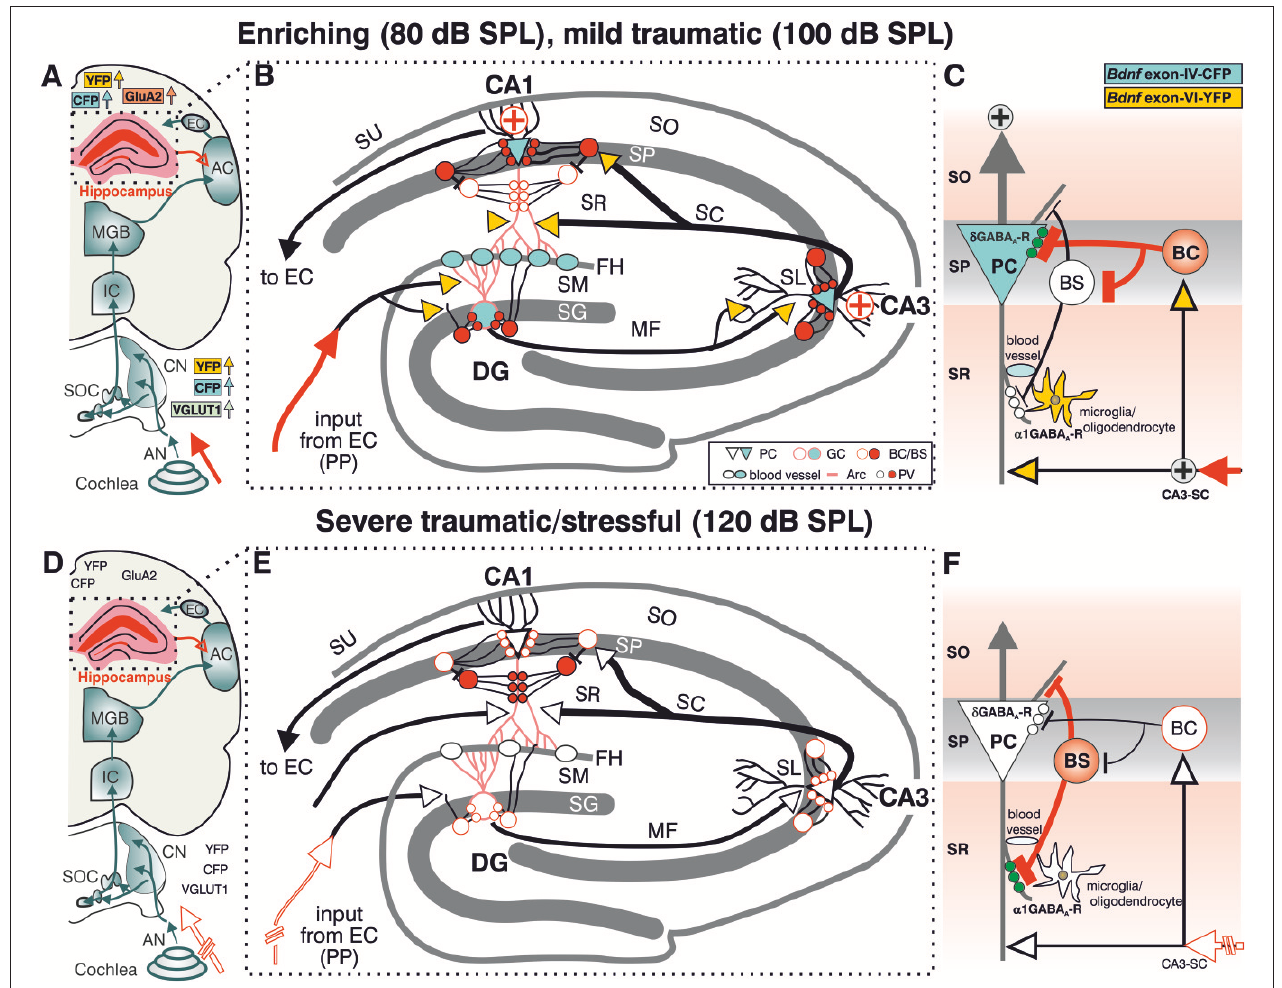
FIGURE 7 | Summary of the location pattern of CFP (blue), YFP (yellow), neuronal (PV) and activity markers (Arc) in the hippocampus. Depicted is the situation in response to enriching or mild traumatic events (80/100 dB SPL) (A–C) or to severe traumatic/stressful events (120 dB SPL) (D–F) . (A,D) Schematic drawing of the auditory pathway including hippocampal connections (red open arrow). (B,E) Schematic drawing of hippocampus with perforant path (PP). (C,D) Schematic drawing of dendritic (BS) and somatic (BC) inhibitory inputs onto a pyramidal cell (PC). CFP, YFP, VGLUT1 ( A , light green), GluA2 ( A , light orange), Arc ( B red dendrites), PV ( B red filled circles), and the δ subunit containing GABA A receptors in PCs (green dots in C ) were shown to be mobilized after exposure to 80 or 100 dB SPL (A–C) but not to 120 dB SPL (D–F). (C,F) The cooperative transcript-specific BDNF release may drive a long-lasting reduction of dendritic ( C , α 1 subunit containing GABA A receptors, white small dots) and increase of perisomatic inhibition ( C , δ subunit containing GABA A receptors, green small dots) of CA1PC by PV expressing inhibitory interneurons (BS, BC) and in parallel possibly improve the recruitment of vascularization ( B,E , blood vessels). This central facilitating or adaptive responsiveness ( A–C , solid red arrow indicating increased input activity) is severely hampered when a critical damage of peripheral auditory input occurs ( D–F discontinuous red lined arrow). L symbol indicates increased output activity in 80 or 100 dB SPL exposed animals (C) . Green dots in (C) represent δ subunit containing GABA A receptors in SP, green dots in (F) represent α 1 subunit containing GABA A receptors in SR. AC, auditory cortex; AN, Auditory nerve; BC, basket cell; BS, bistratified cell; CA3-SC, excitatory input from CA3 Schaffer collaterals; CN, cochlear nucleus; DG, dentate gyrus; EC, entorhinal cortex; FH, fissura hippocampalis; GC, granule cell; IC, inferior colliculus; MF, mossy fibers; SC, Schaffer collaterale; SG, stratum granulare; SL, stratum lucidum; SM, stratum moleculare; SO, stratum oriens; SOC, superior olivary complex; SP, stratum pyramidale; SR, stratum radiatum; SU, subiculum.